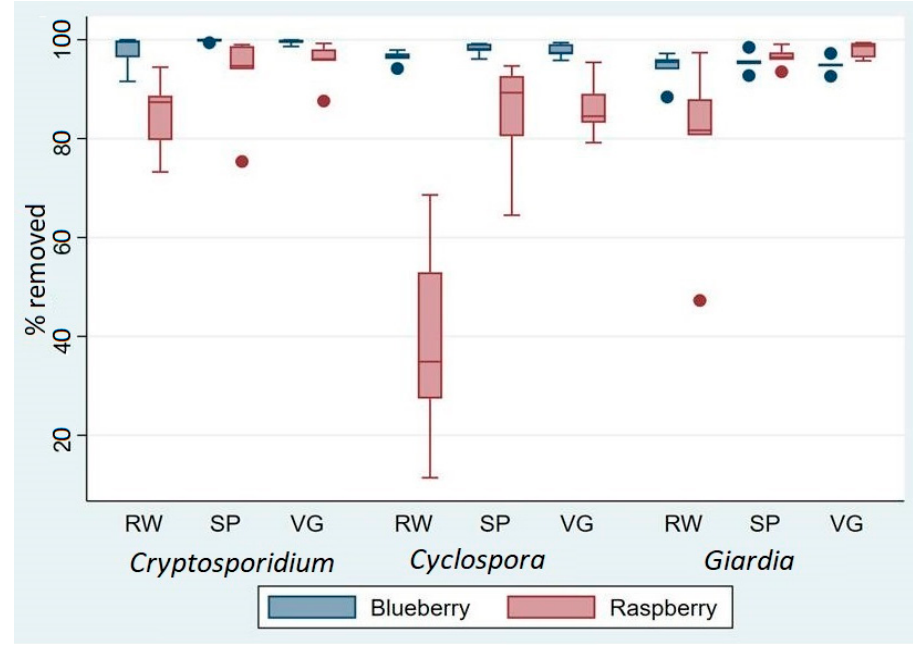
Figure 2. Box plot of the percentage removal of parasites by three washing techniques. Dots repre- sent outliers. Table 1. Percentage removal of parasites from raspberries and blueberries after washing with three different washing techniques in five replicates.